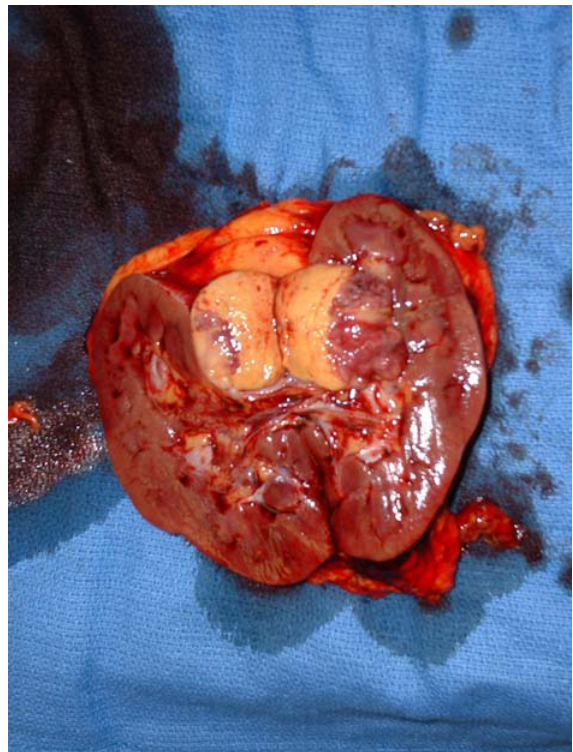
FIGURE 1 . Photograph showing gross appearance of bisected kidney with hilar mass.